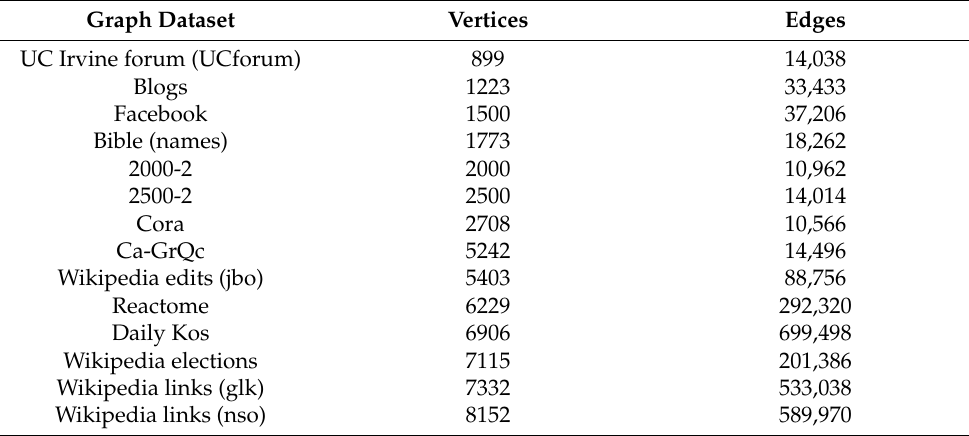
Table 1. The input graph datasets used in